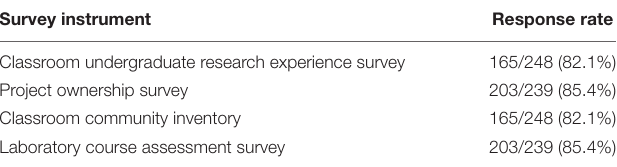
TABLE 2 | Survey administration response